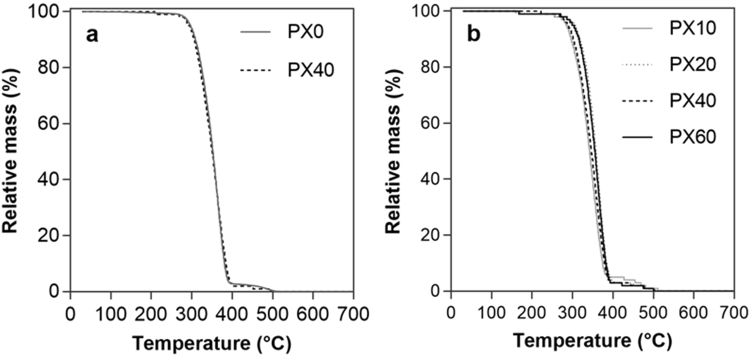
TGA curves of a) selected PX flat sheet membranes; and b) PX hollow fibre membranes.